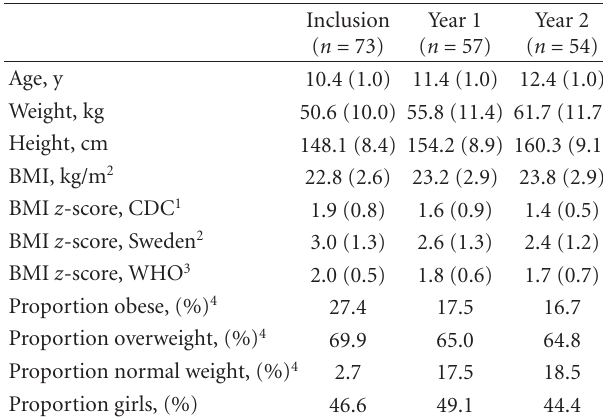
Table 1: Characteristics of children at inclusion and after one and two years of participation, respectively, presented as mean (SD) or percentage